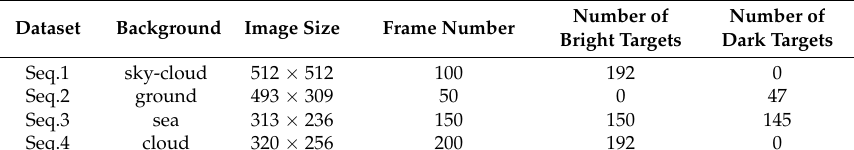
Table 1. Detailed information of our datasets.